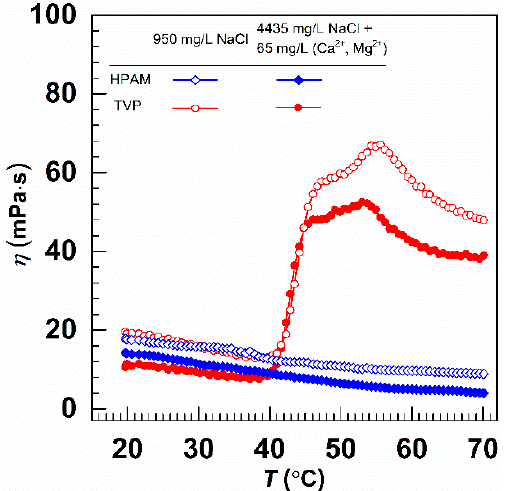
Figure 2. Viscosity changes during temperature scan for 0.1% TVP or HPAM solution in the presence of 950 mg/L NaCl or 4500 mg/L TDS with 65 mg/L Ca 2+ and Mg 2+ . Shear rate, 7.34 s − 1 ; heating rate, 2 ° C/min.